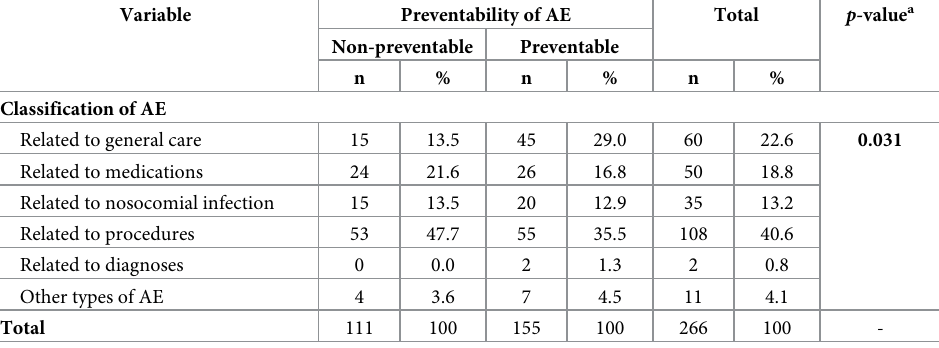
Table 4. Association between the preventability of adverse events and classification of the events according to their